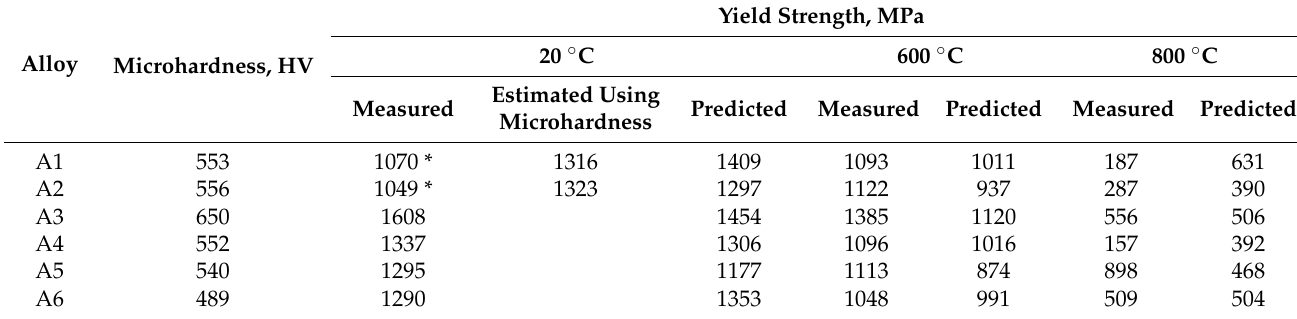
Table 4. Measured and predicted yield strength for 20 ◦ C, 600 ◦ C and 800 ◦ C and microhardness of the model alloys Alloy Microhardness, HV